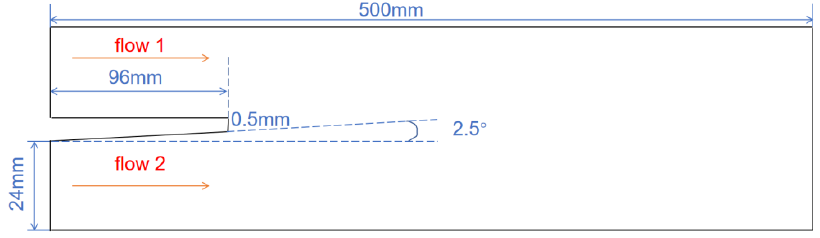
Figure 4. Experimental schematic diagram of Goebel and Dutton.